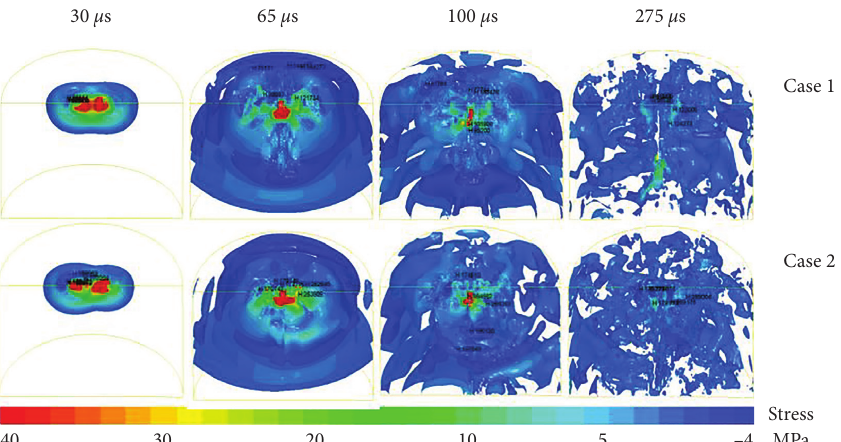
Figure 5: Stress nephogram: the marked point indicates the maximum value of tensile stress, which always appears close to the main splitting surface.